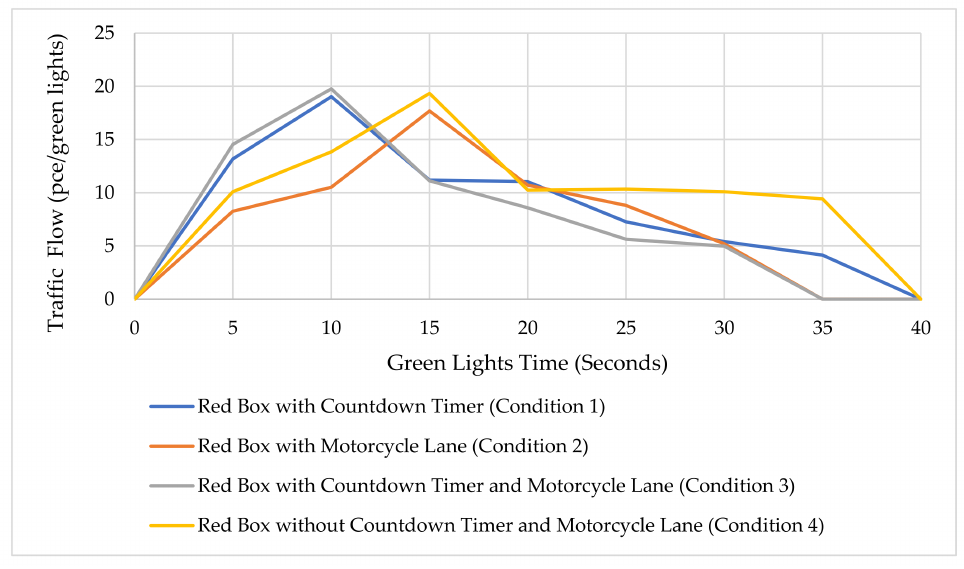
Figure 7. Traffic flow per green